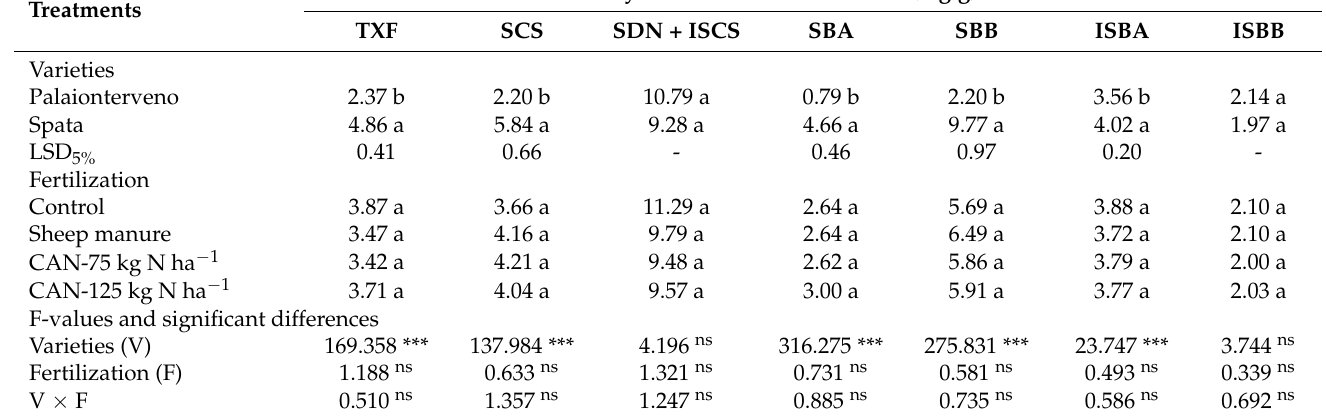
Table 9. Effects of two milk thistle varieties (Palaionterveno and Spata) and fertilization regimes (sheep manure and inorganic fertilizer) on the content of silymarin active constituents in fruits of milk thistle in